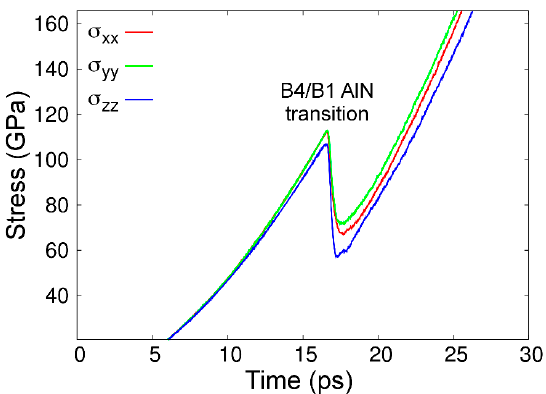
Figure 9. Stress as a function of time/pressure in the B4-AlN simulation box during the CMD runs. The abrupt drop in stress at ≈ 17 s ( ≈ 110 GPa) corresponding to the formation of small B1-AlN grains, which is the first step for the B4- to B1-AlN phase transformation.